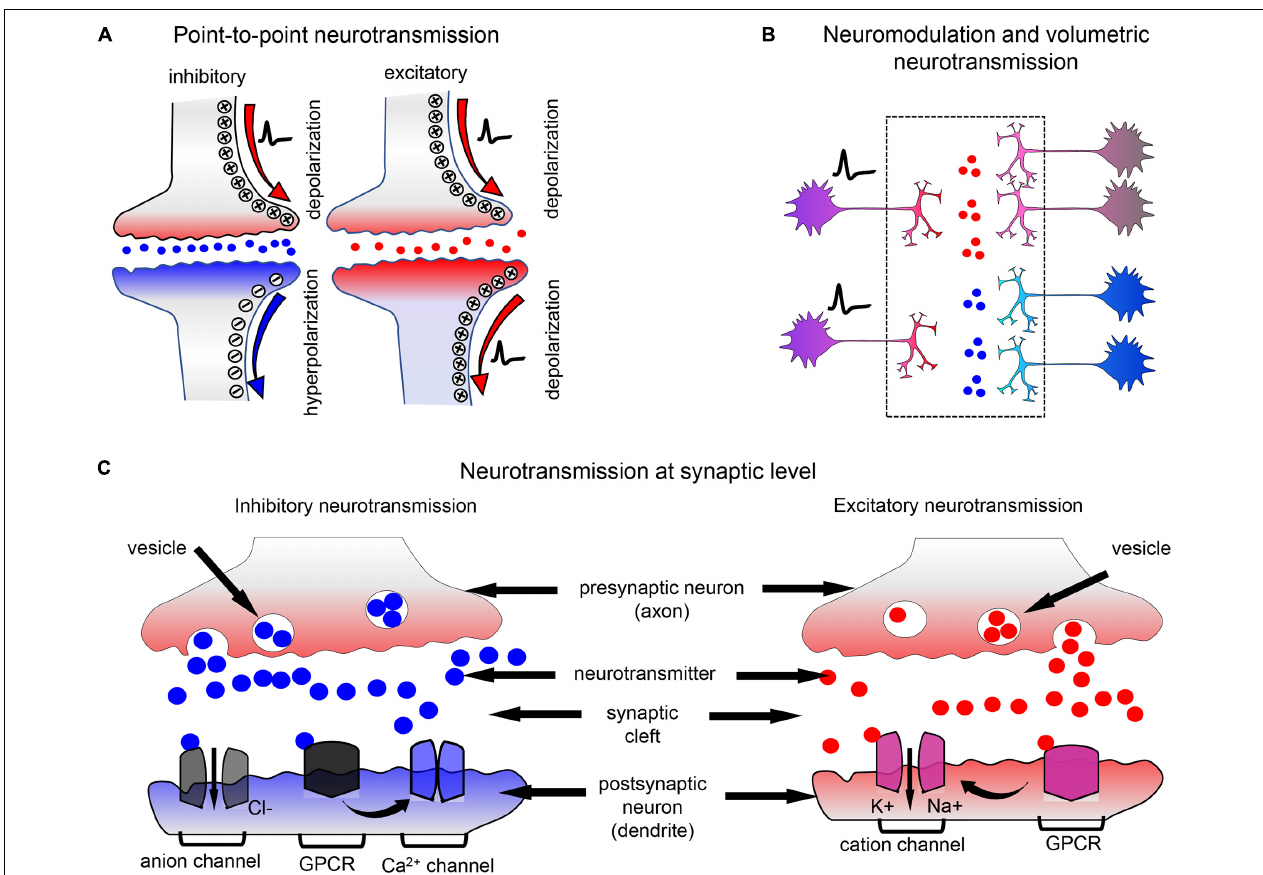
FIGURE 1 | Neurotransmission and neuromodulation principles. (A) In local neurotransmission, neurotransmitters packed in vesicles are released into the synaptic cleft and interact with the ionotropic receptors of neurotransmitters, which are typically ion channels. The interaction causes receptor with inhibitory or excitatory neurotransmitter channel to open to negatively or positively charged ions. The post-synaptic neuron is inhibited (blue) or excited (red). Neurotransmitters released by a presynaptic neuron act only on the single post-synaptic neuron and, after interaction with ionotropic receptors, are rapidly destroyed in the synaptic cleft. (B) In neuromodulation and volumetric transmission, neuromodulators released by a single neuron act simultaneously on the groups of neurons, modulating their synaptic strength. (C) Neurotransmission at synaptic level: on the left: the inhibitory neurotransmitter is released in the synaptic cleft and activates anion channels and GPCR receptors. Activation of GPCR receptors by the inhibitory neurotransmitters, such as GABA, negatively regulates calcium channels. On the right: the excitatory neurotransmitter is released in the synaptic cleft and activates cation channels and relevant GPCR